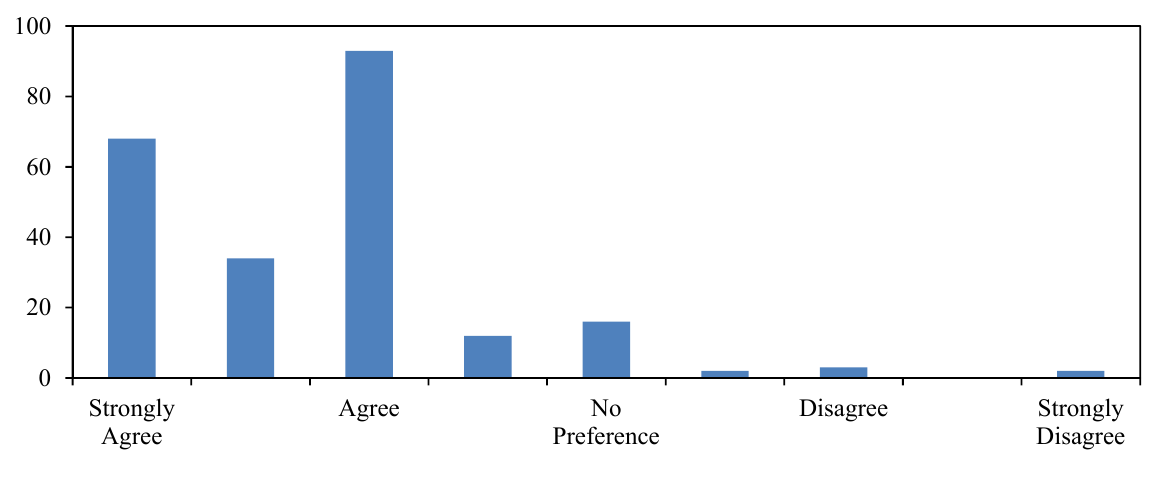
Figure 5. Graph of responses to the statement “I prefer to analyze my own data (using or not using a